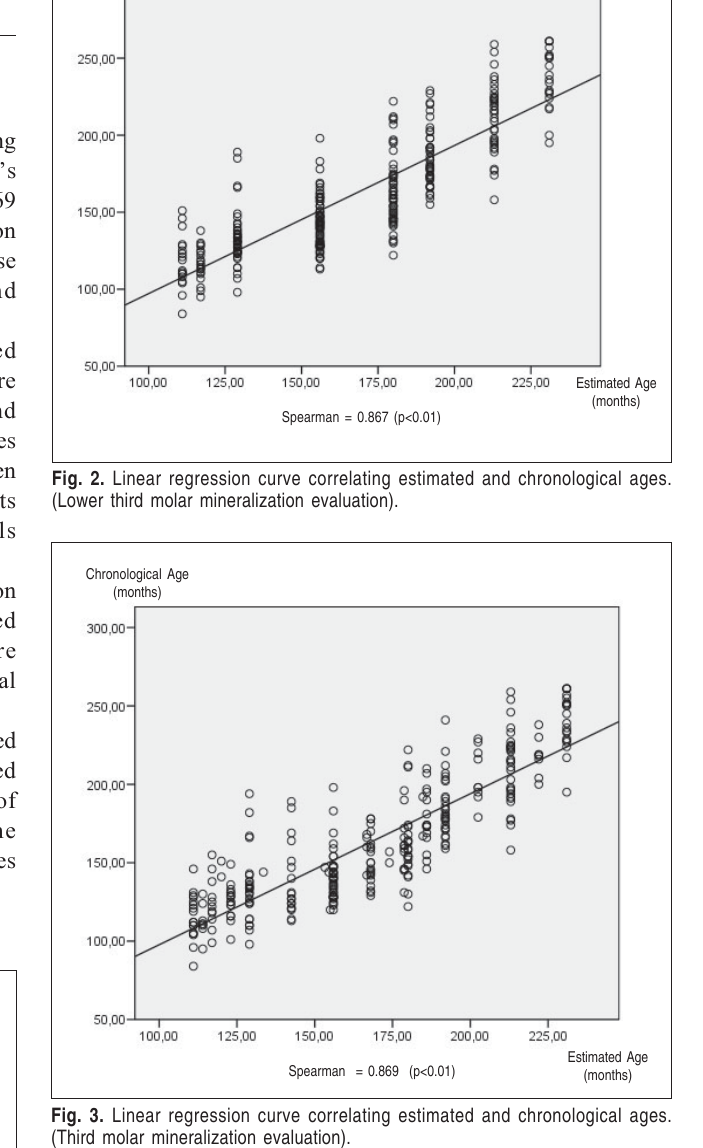
Spearman = 0.869 (p<0.01) Fig. 3. Linear regression curve correlating estimated and chronological ages. (Third molar mineralization